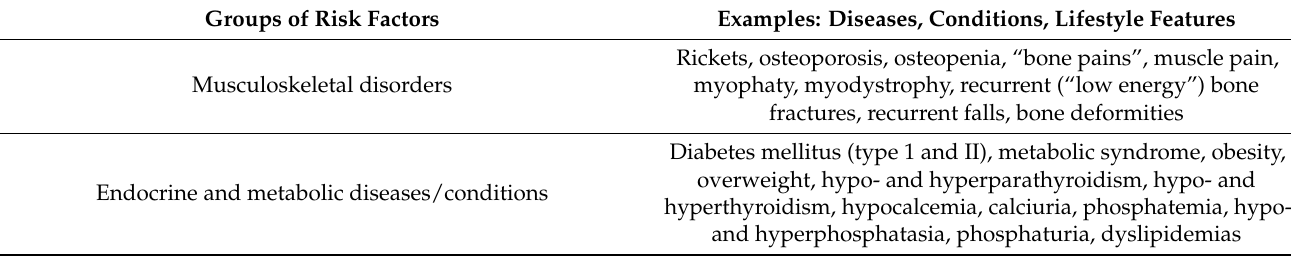
Table 3. Risk groups for vitamin D deficiency or insufficiency according to a large body of published evidence and to Bleizgys